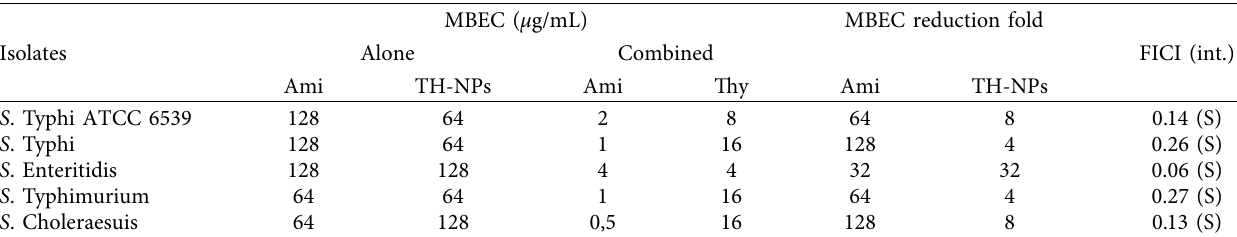
Table 3: Minimum bioflm eradication concentration (MBEC) of amikacin and thymol-loaded PLGA and the fractional inhibitory concentration index (FICI) of combination against S . enterica